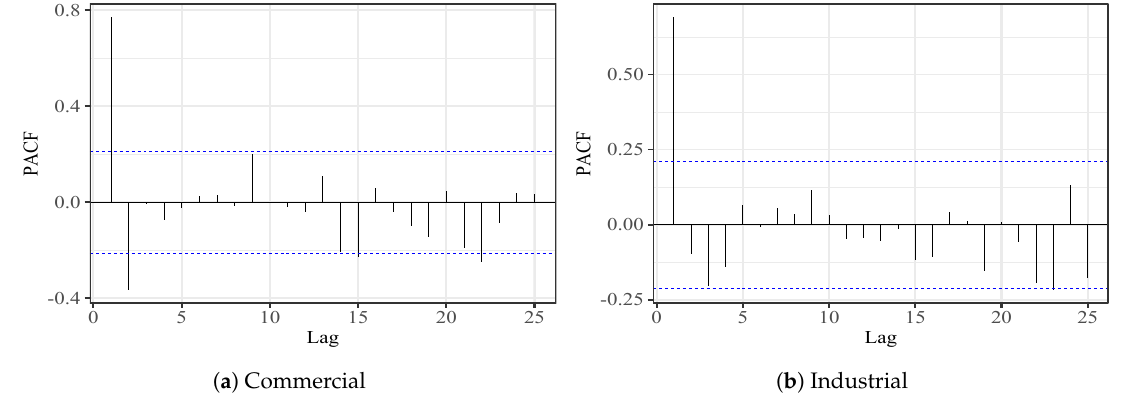
Figure 11. Partial autocorrelation for residue of proposed model in each